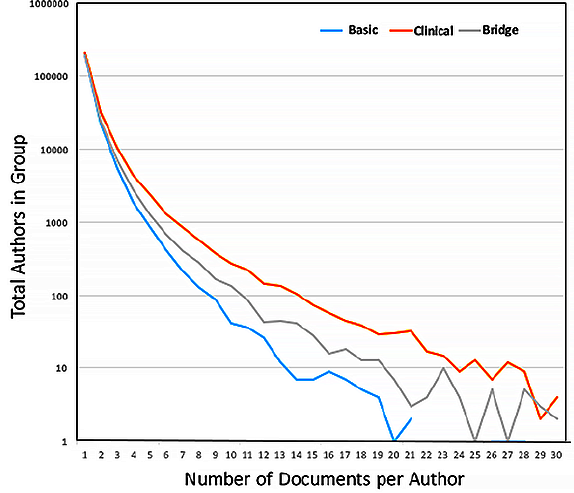
Figure 1. Distribution of the number of papers submitted by individual authors in the category journals.